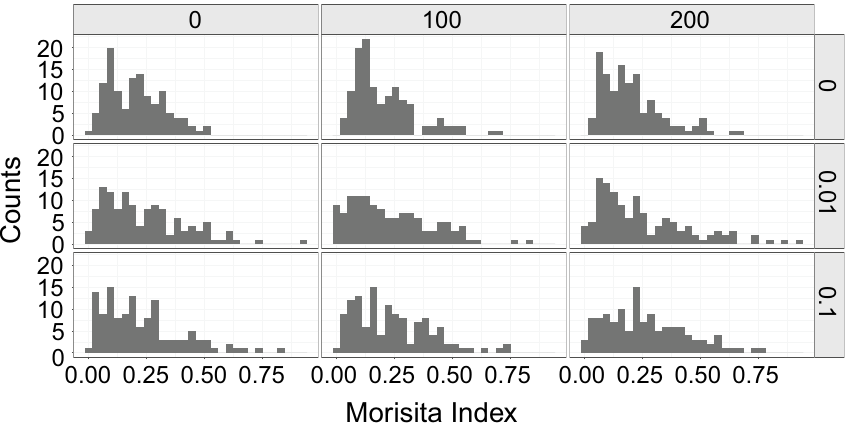
Figure 5. Histograms of the Morisita dissimilarity index for pairs of simulated communities. Rows: fraction of the connectivity matrix filled with non-zero values (see methods). Columns: Number of fixed shared individuals (out of a total of 500) at the start of each simulation.